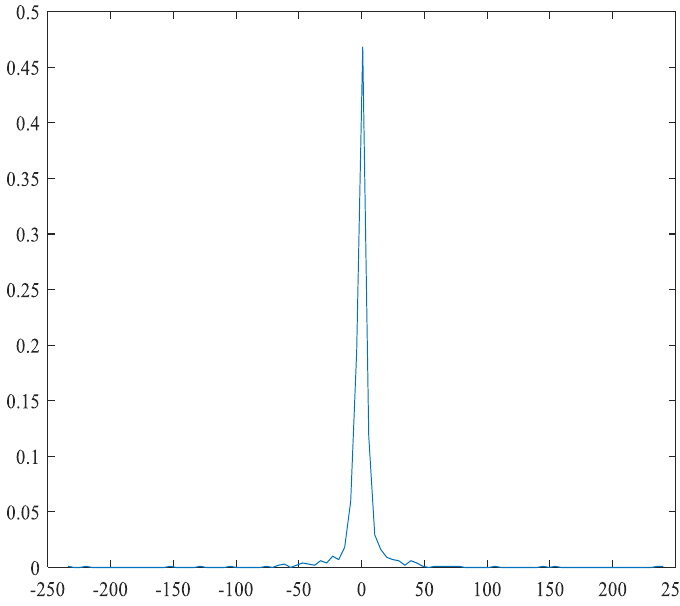
Figure 5. Probability density of GP increment.